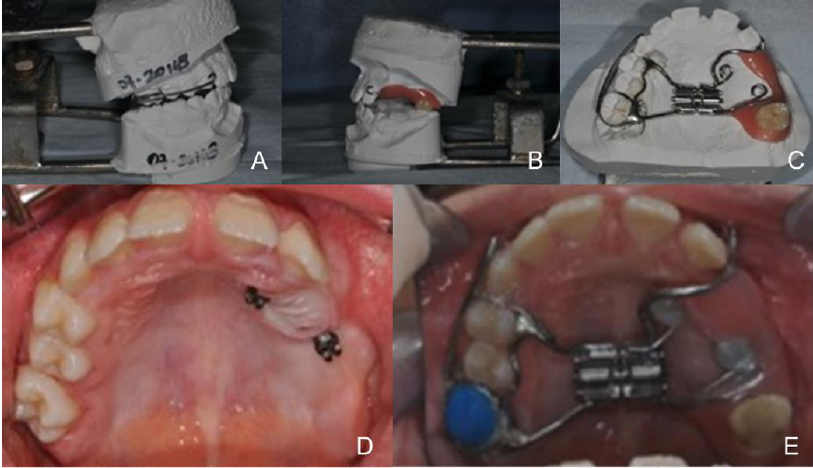
Figure 6. Realization of the hybrid rapid palatal expander with side hooks for the extraoral traction. The orthodontic miniscrews (Sweden e Martina, Padua, Italy) made of grade 5 tita- nium with a self-tapping thread with a diameter of 1.80 mm and a transmucosal neck of 1.30 mm were used. The 8 mm long miniscrews allow an immediate load of 50 to 300 g